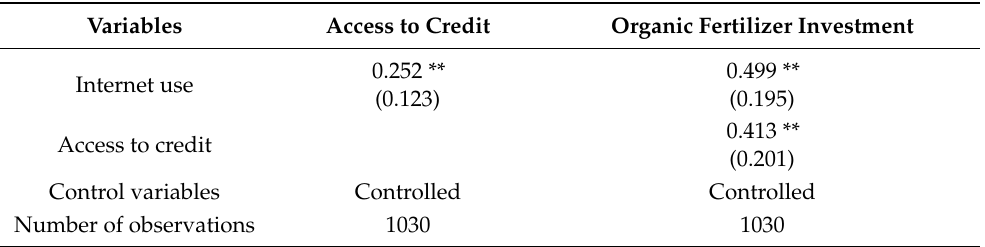
Table 6. Mediation effect estimation